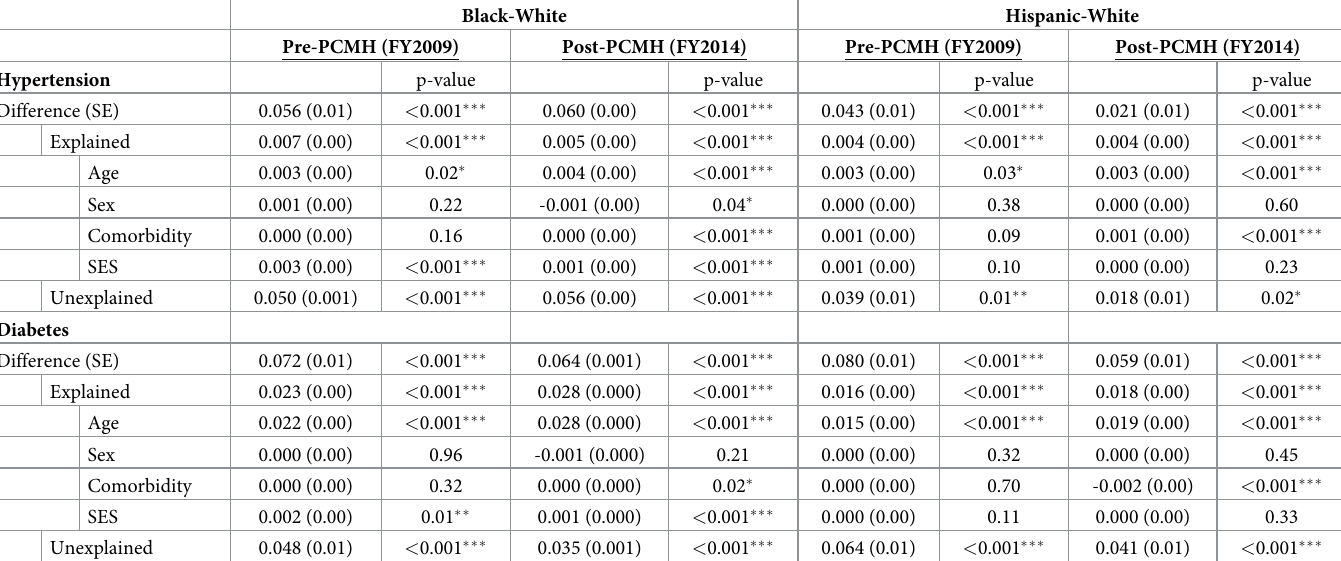
Table 2. Decomposing racial-ethnic disparities in hypertension and diabetes control before and after VHA patient-centered medical home implementation.